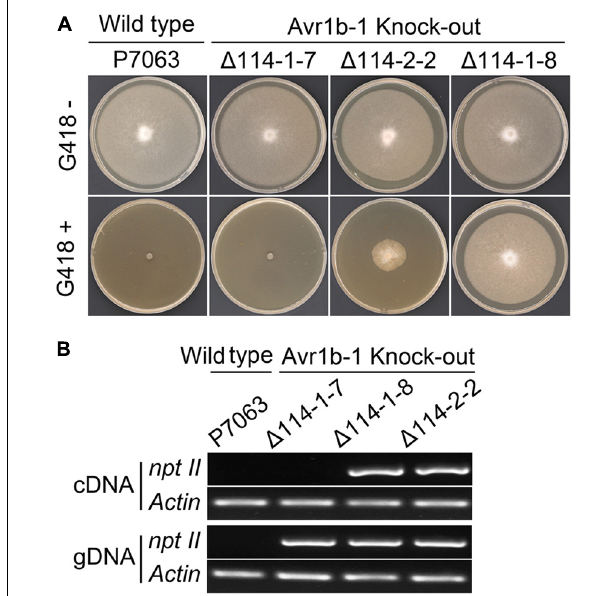
FIGURE 4 | G418 sensitivity of Avr1b-1 knock-out transformants. (A) Wild-type P7063 and three selected Avr1b-1 deletion transformants cultured on clarified V8 medium with or without 50 µ g/ml G418. Transformants (cid:49) 114-1-7 and (cid:49) 114-2-2 were isolated from G418 regeneration medium and then subcultured in V8 medium. Transformant (cid:49) 114-1-8 was maintained on V8 medium containing 50 µ g/ml G418. (B) PCR detection of npt II sequences in genomic DNA and RNA of Avr1b-1 knock-out transformants and P7063 with primer pair qNptF/R. P. sojae Actin was used as the reference